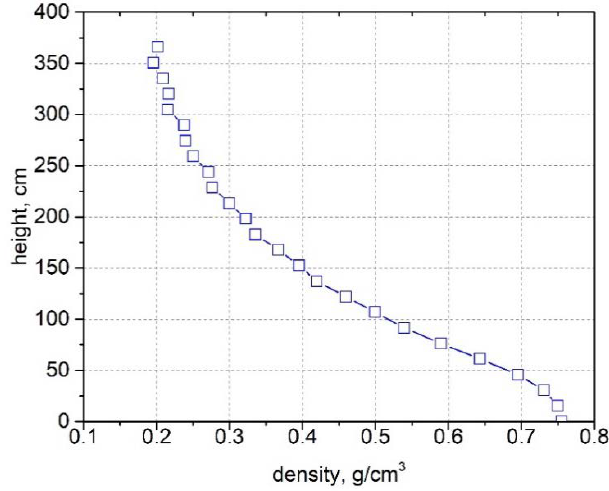
Figure 5. Moderator density profile in BWR reactor core.